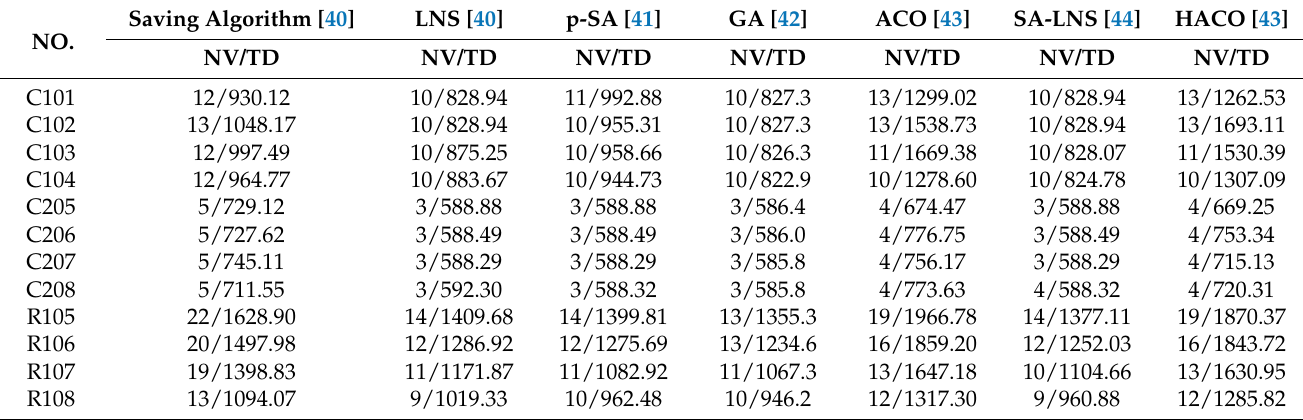
Table 6. The other intelligent algorithms experimental results for the large-scale Solomon’s